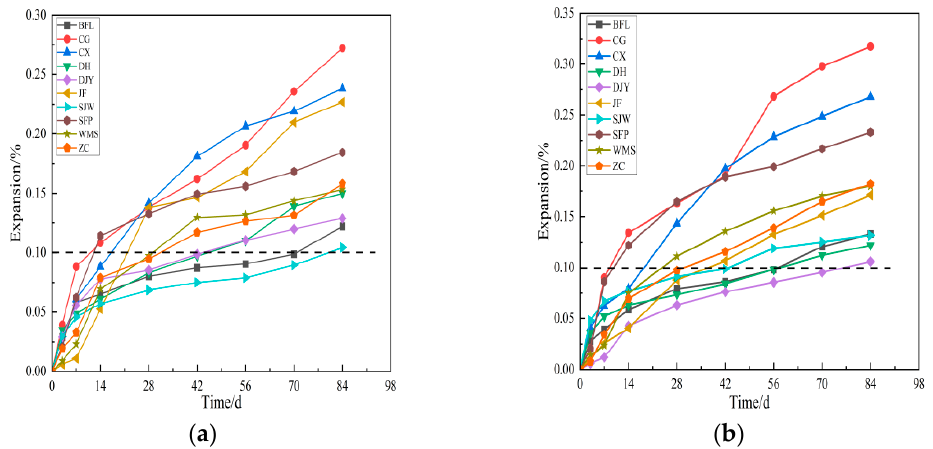
Figure 7. The expansion of rocks with ( a ) 2.5–5 mm, ( b ) 5–10 mm particle size at 60 °C. In addition to the particle size of aggregates, curing temperature also affects the ex- pansion of samples. Figure 8 shows the expansion of samples prepared by aggregates of 2.5–5 mm and 5–10 mm particle size, cured in 1 mol/L TMAH solution at 80 °C. The ex- pansion data of specimens at 60 °C and 80 °C were analysed, the expansion of most of examples cured at 80 °C was about 30% larger than that cured at 60 °C. From Figure 8, compared with 2.5–5 mm samples, the differences in the expansion of 5–10 mm samples were more obvious at early curing age. When the curing age was 42 days, the expansions of BFL, DH, DJY and SJW with 2.5–5 mm particle size cured at 80 °C were 0.087%, 0.097%, 0.099% and 0.075%, respectively, were less than 0.1%, and tended to be stable. The expan- sions of them were greater than 0.1% cured at 84 days curing age.